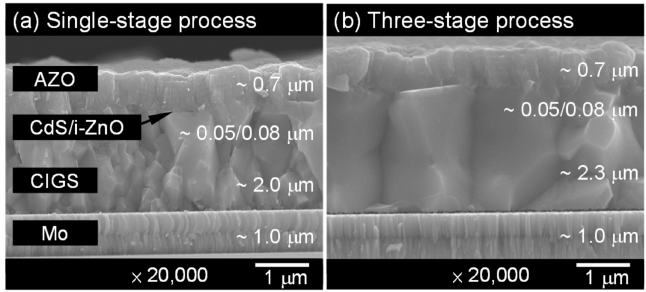
Figure 9. SEM cross-sectional views of CIGS solar cells prepared by ( a ) the single-stage process and ( b ) the three-stage